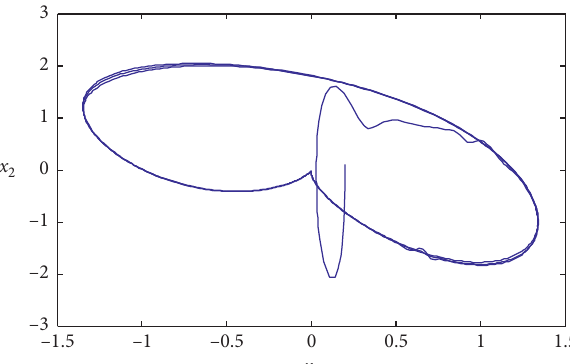
Figure 8: Phase portrait of states x